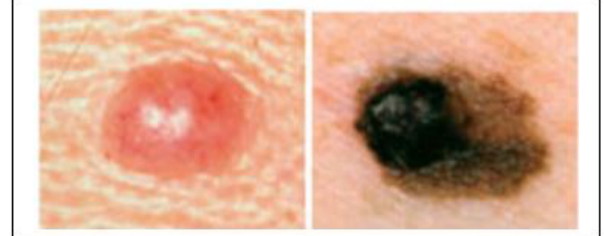
Figure 2. Benign Melanoma and Malignant